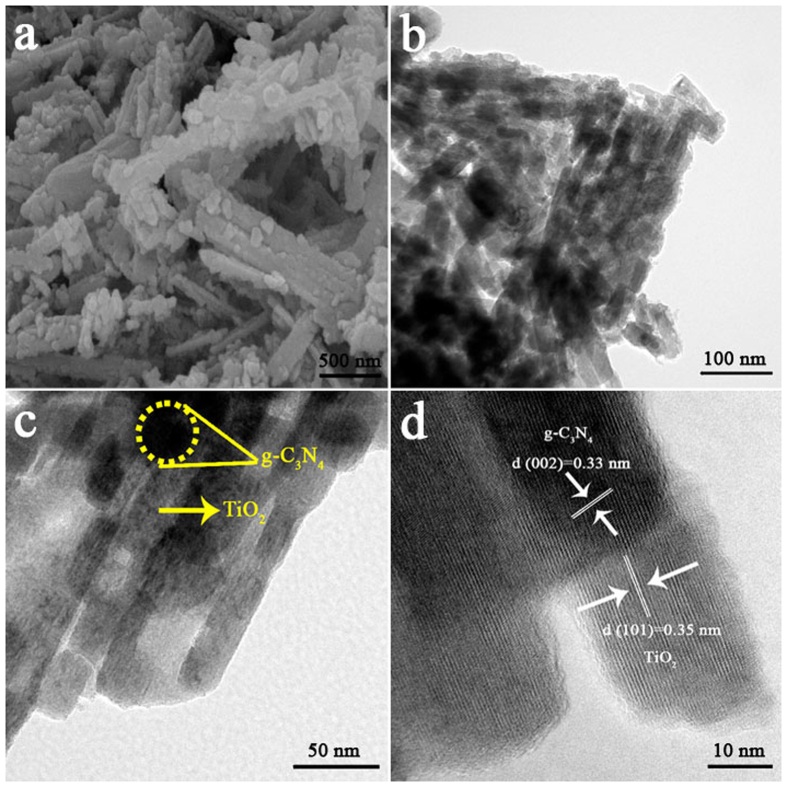
SEM and TEM images of b-TiO2/g-C3N4: SEM image of b-TiO2/g-C3N4 (a), TEM image of b-TiO2/g-C3N4 (b,c), and HRTEM image of b-TiO2/g-C3N4 (d).